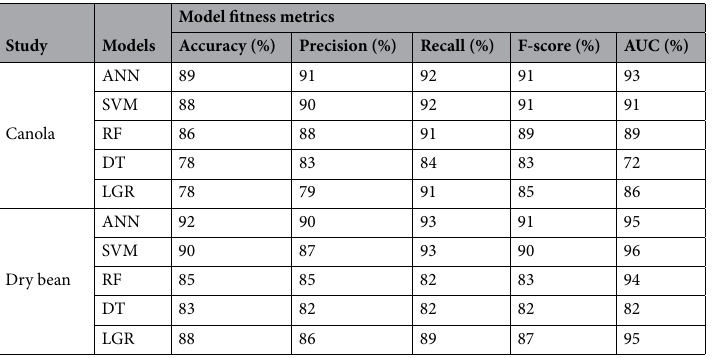
Table 3. Evaluation of fitness of artificial neural networks (ANN), support-vector machine (SVM), random forest (RF), decision trees (DT), and logistic regression (LGR) machine-learning models used in classification analyses of canola and dry bean data sets that associated incubation temperature and duration of leaf wetness conditions with incidence of Sclerotinia stem rot disease. AUC represents the area under the receiver operating characteristic